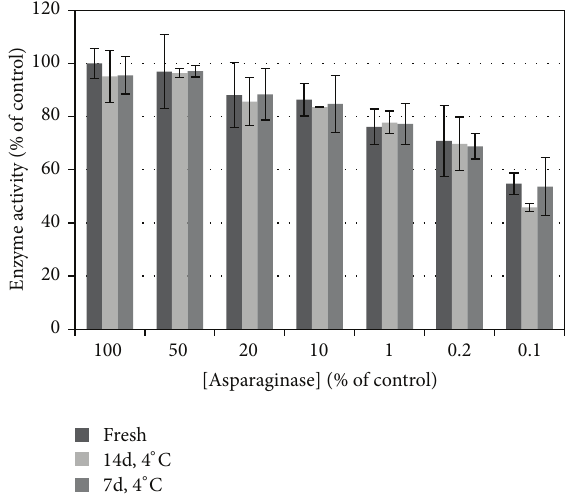
Figure 3: ASNase depletes supernatant asparagine in vitro. All cold- stored asparaginase treatment groups reduce asparagine levels com- pared to untreated cells, 𝑃 < 0.0001 . The effects of types of cold storage treatments are not significant ( 𝑃 > 0.05 ).